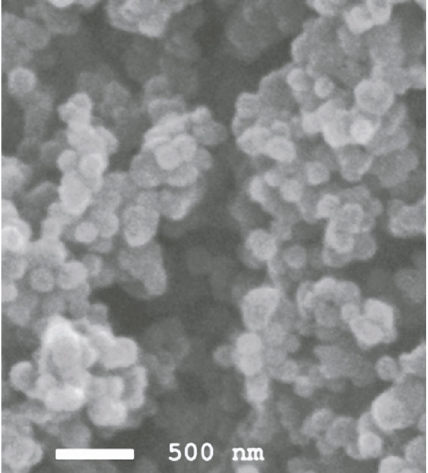
Figure 3: Scanning electron micrograph of nanoparticles composited from nanochitosan and nano-TiO